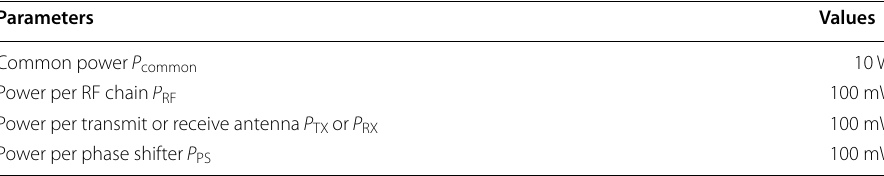
Table 1 Parameters for the power consumption model [38] Parameters Values Common power P common 10 W Power per RF chain P RF 100 mW Power per transmit or receive antenna P TX or P RX 100 mW Power per phase shifter P PS 100